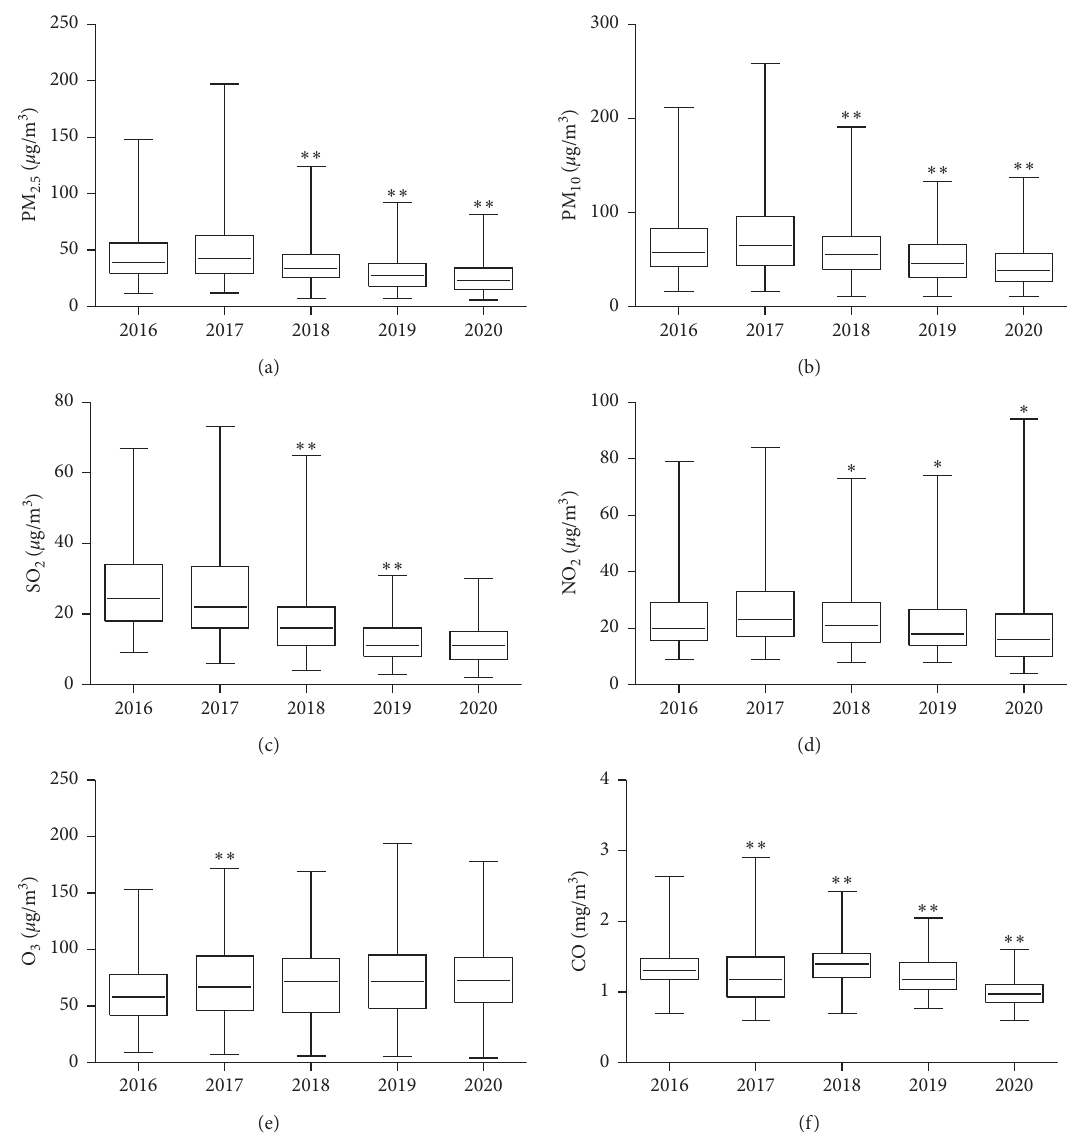
Figure 1: Box plot of the annual air pollution concentration in Ganzhou City, 2016–2020: (a) annual distribution of PM (d) annual distribution of NO 2 concentrations in 2016–2020, (e) annual distribution of O 3 concentrations in 2016–2020, and (f) annual distribution of CO concentrations in 2016–2020. “ ∗ ” indicates a difference (0.001 ≤ P < 0.05) between the contaminant concentration in the marker year and the previous year comparison. “ ∗∗ ” indicates more pronounced differences ( P < 0.001) in pollutant concentrations in the marker year than in the previous